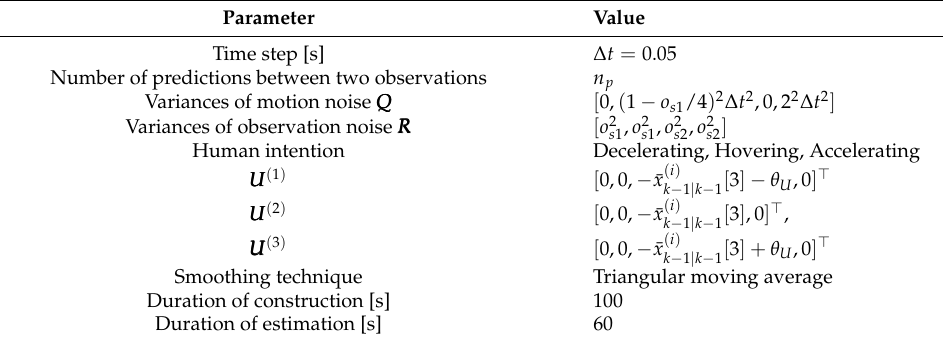
Table 2. Parameters of the proposed